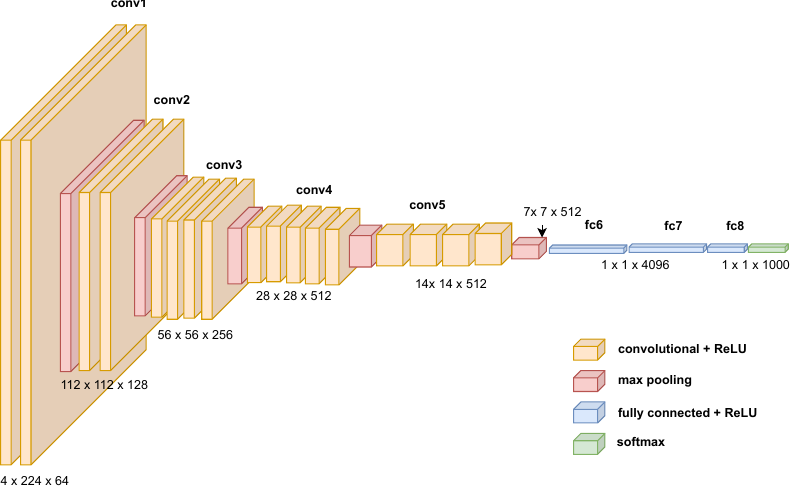
Figure 2. Architecture of the well-known CNN model VGG19. The VGG19 network contains convolutional layers, max-pool layers, fully connected layers, and a soft-max classification